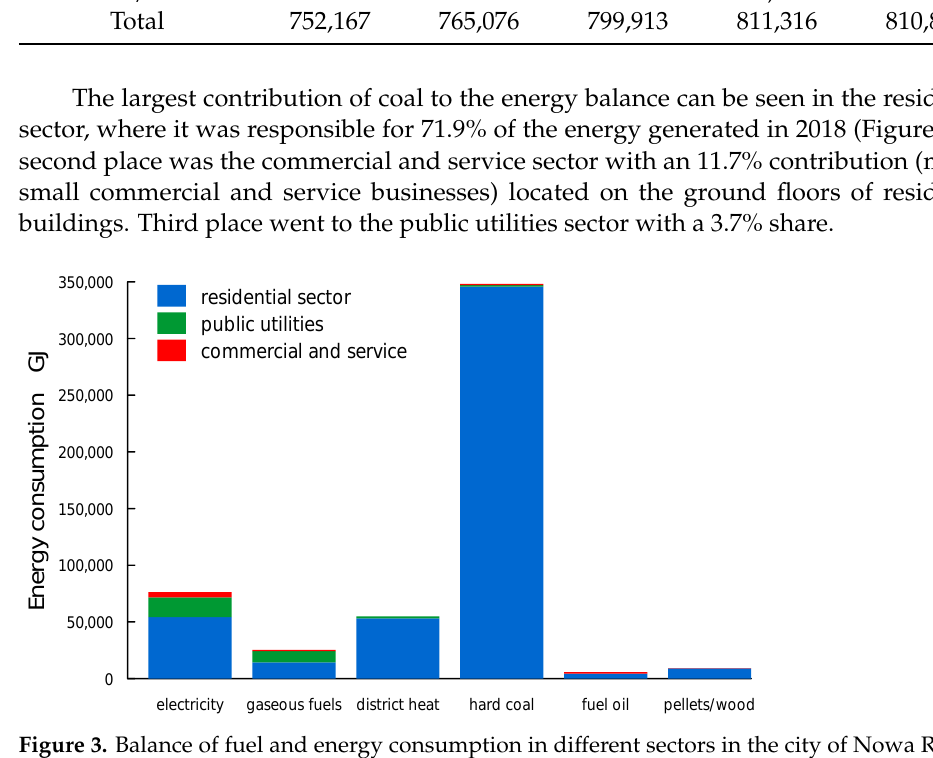
Figure 3. Balance of fuel and energy consumption in different sectors in the city of Nowa Ruda in 2018